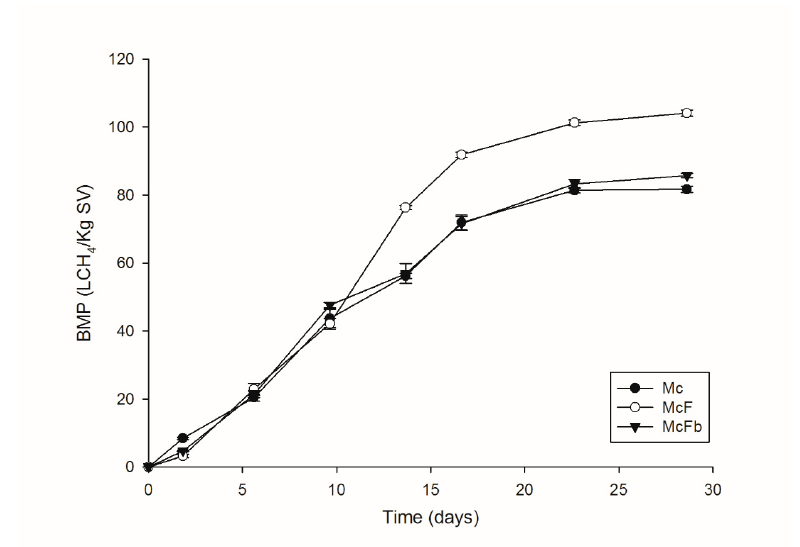
Figure 3. Accumulated production of methane for the anaerobic digestion of macroalgae consortium employing two pretreatments and a control. Macroalgae consortium (Mc); macroalgae consortium + fungal broth (McFb); macroalgae consortium + fungi (McF).